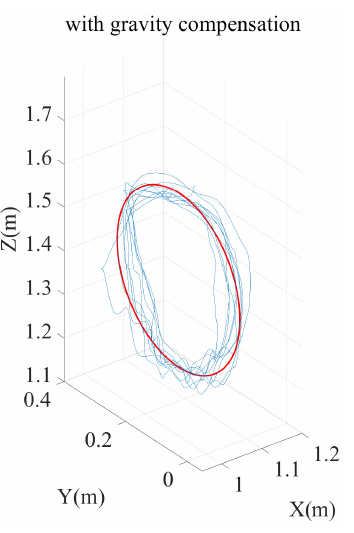
Figure 13. End-point trajectory of the UW during experiments in 3D without gravity compensation of K-handler.